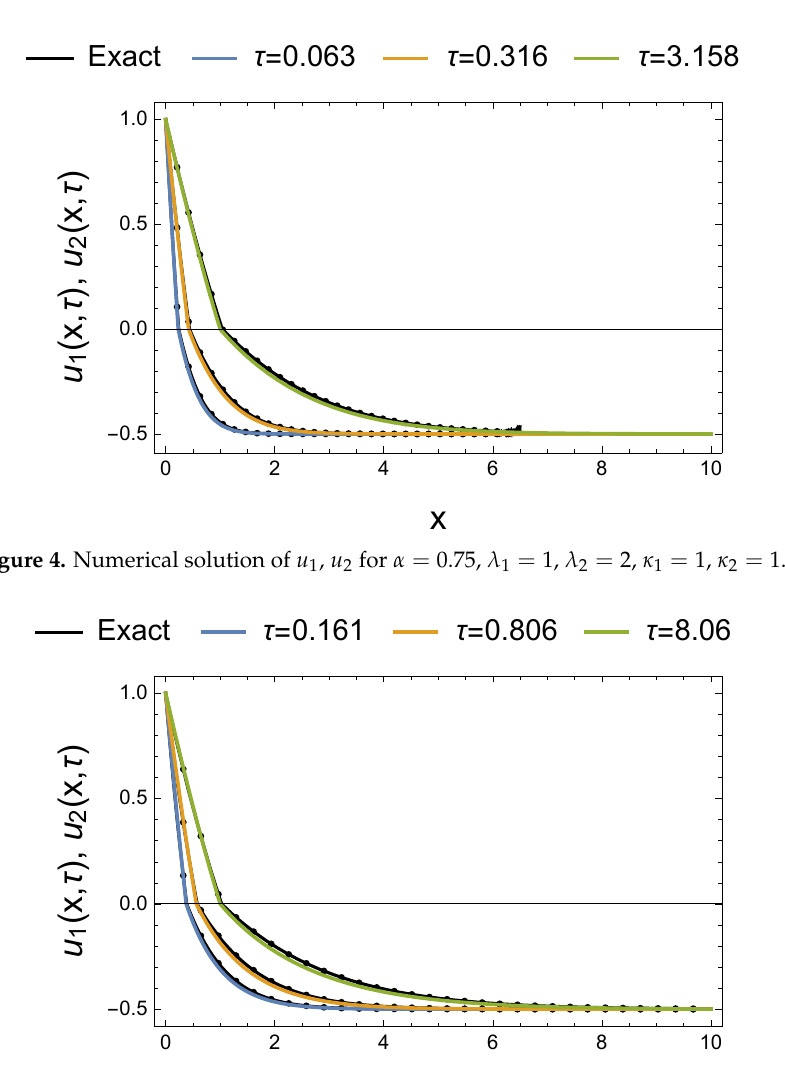
Figure 3. Numerical solution of u 1 , u 2 for α = 1, λ 1 = 1, λ 2 = 2, κ 1 = 1, κ 2 = 1.